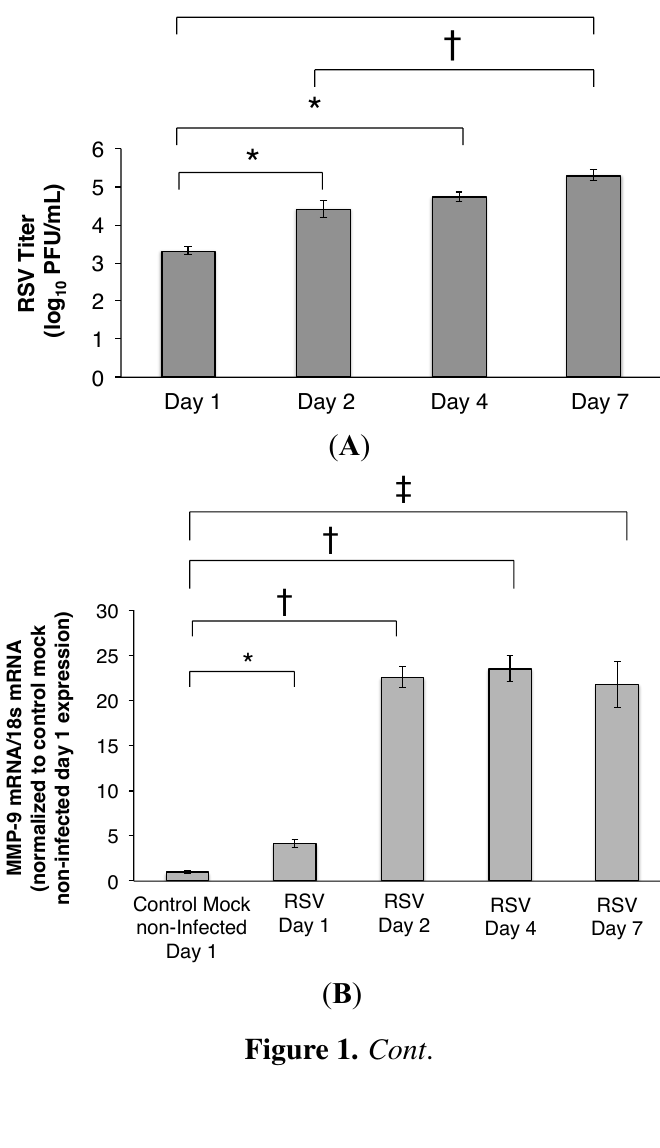
Figure 1. Cont Figure 1. Cont .